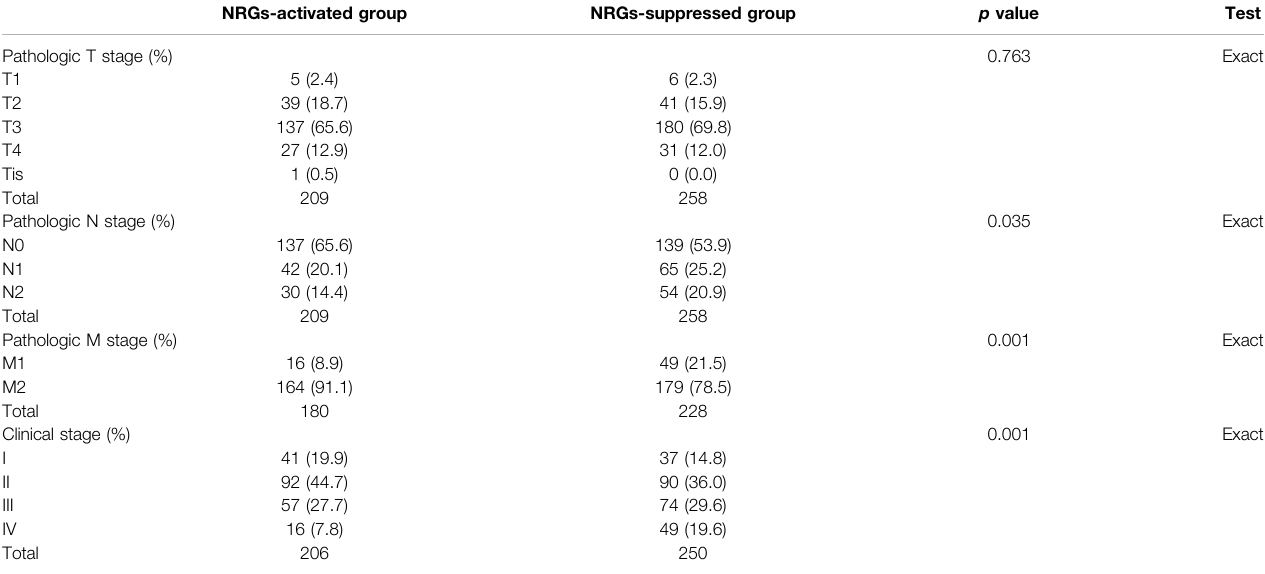
TABLE 1 | Clinical characteristics of colon cancer patients in the NRGs-activated and NRGs-suppressed group. NRGs-activated